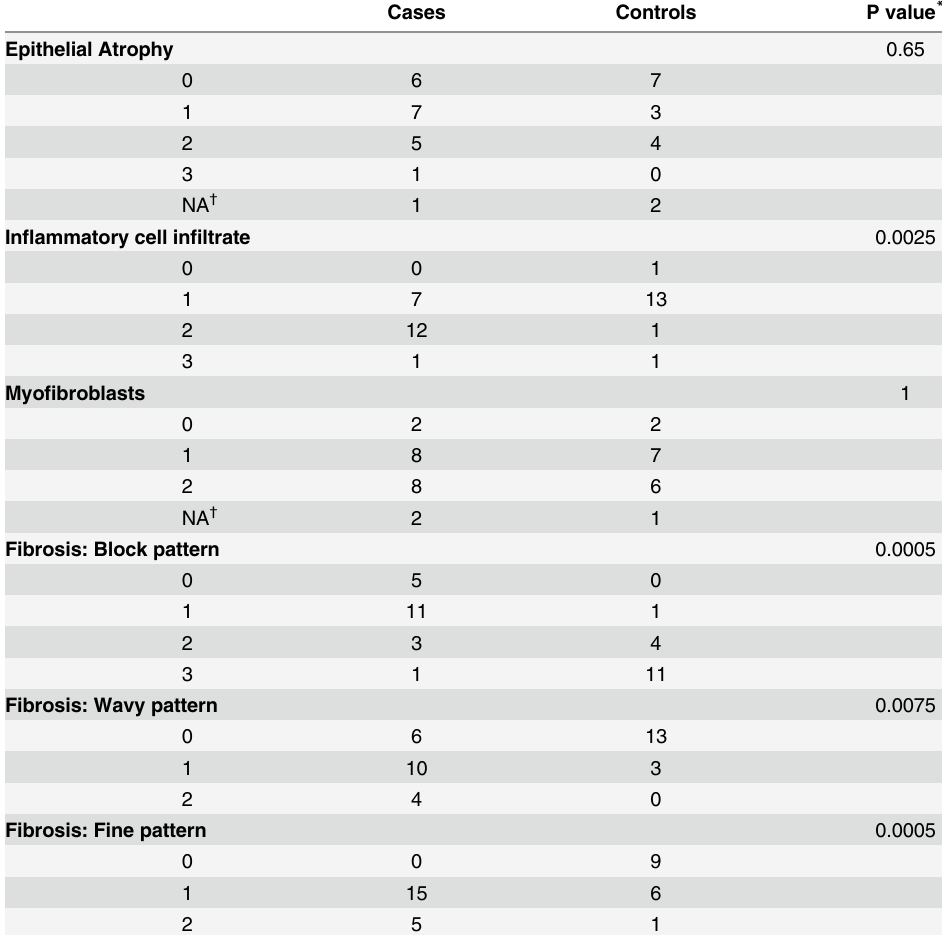
Table 2. Sample characteristics by Hematoxylin and Eosin staining.